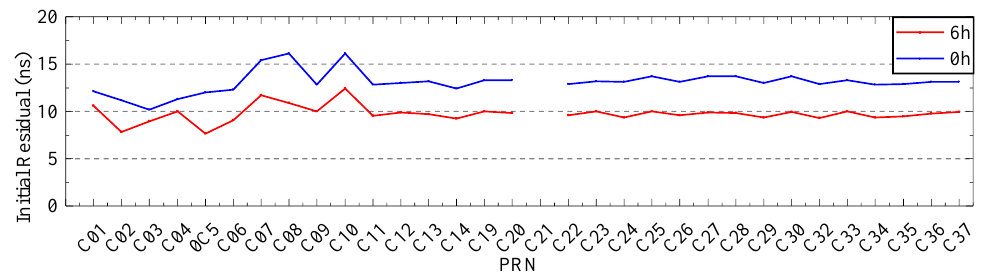
Figure 20. The initial residual value with a DOY of 198.